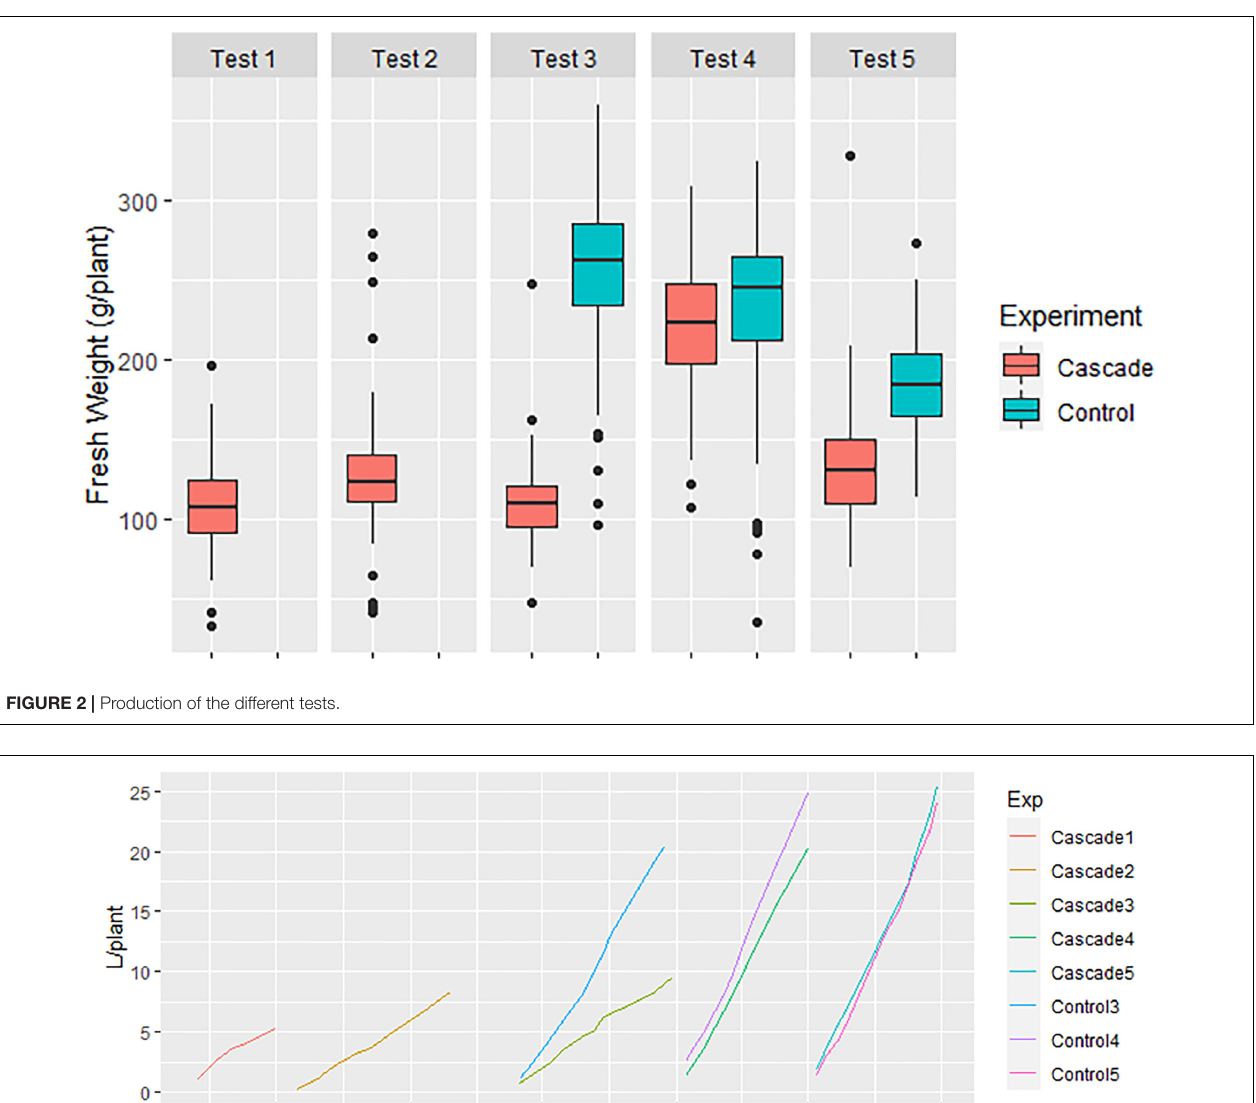
FIGURE 3 | Irrigation per plant of the different